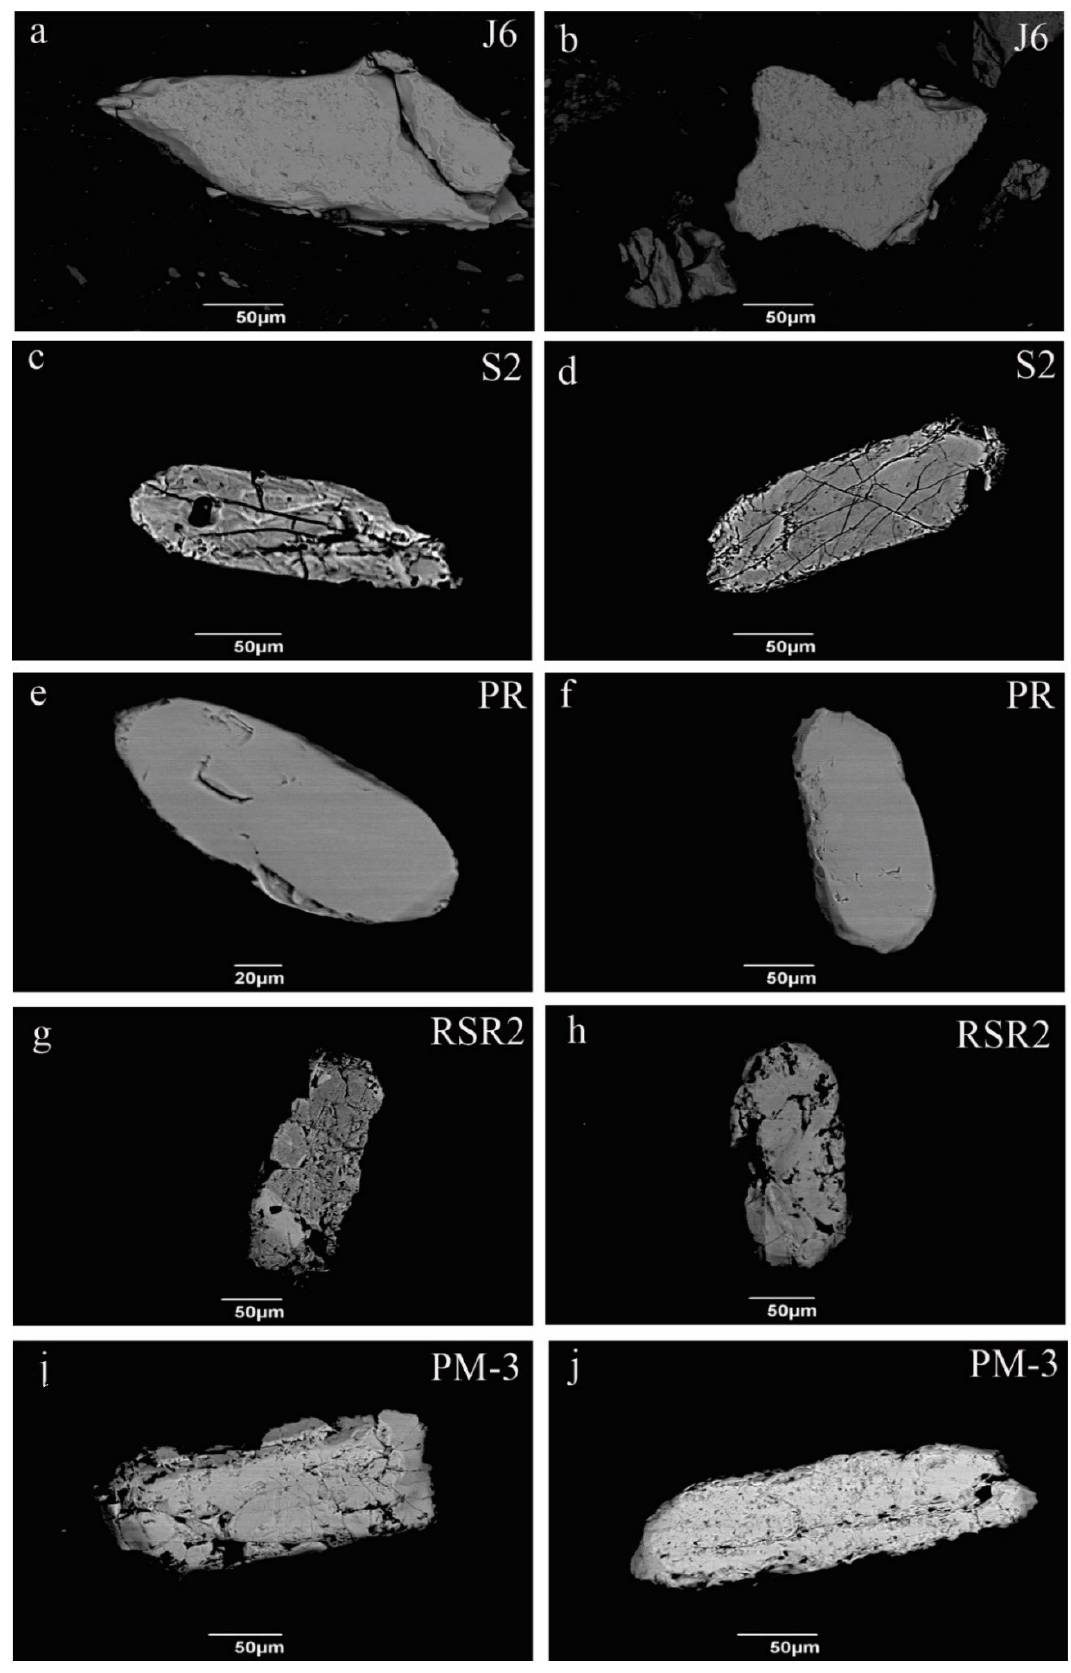
Figure 9. SEM-EDS images of zircon grains from different samples of sands analysed in the study. ( a , b ): sample J6; ( c , d ): sample S2; ( e , f ): sample PR; ( g , h ): sample RSR2; ( i , j ): sample PM-3.